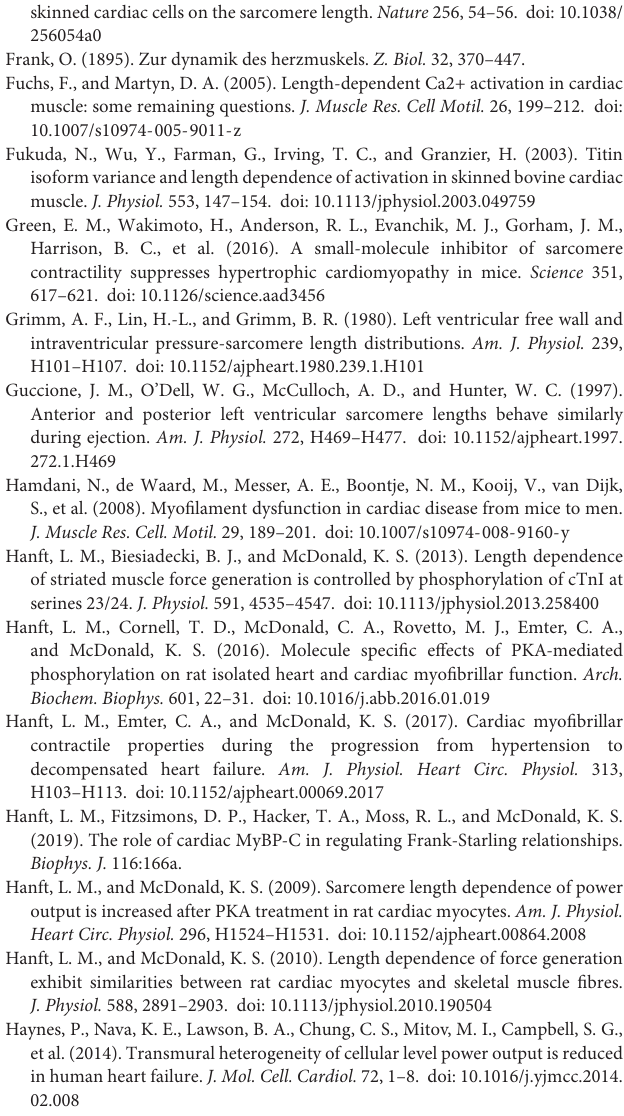
FIGURE S1 | Maximal Ca 2 + activated tension- Effects of sex. Male, N = 8 hearts, n = 15 cardiac myocyte preparations. Female, N = 7 hearts, n = 14 cardiac myocyte preparations. Different symbols indicate data points from each heart sample. Linear mixed model, p = 0.549. FIGURE S2 | Rate of force development ( k tr ) during maximal Ca 2 + activation- Effects of sex. Male, N = 7 hearts, n = 11 cardiac myocyte preparations. Female, N = 7 hearts, n = 12 cardiac myocyte preparations. Different symbols indicate data points from each heart sample. Linear mixed model, p =